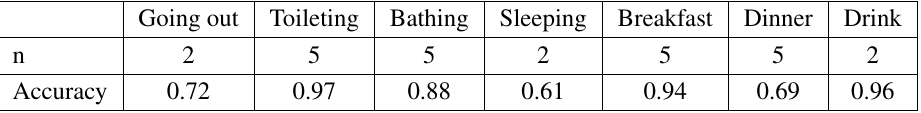
Table 6. Real-life database generation